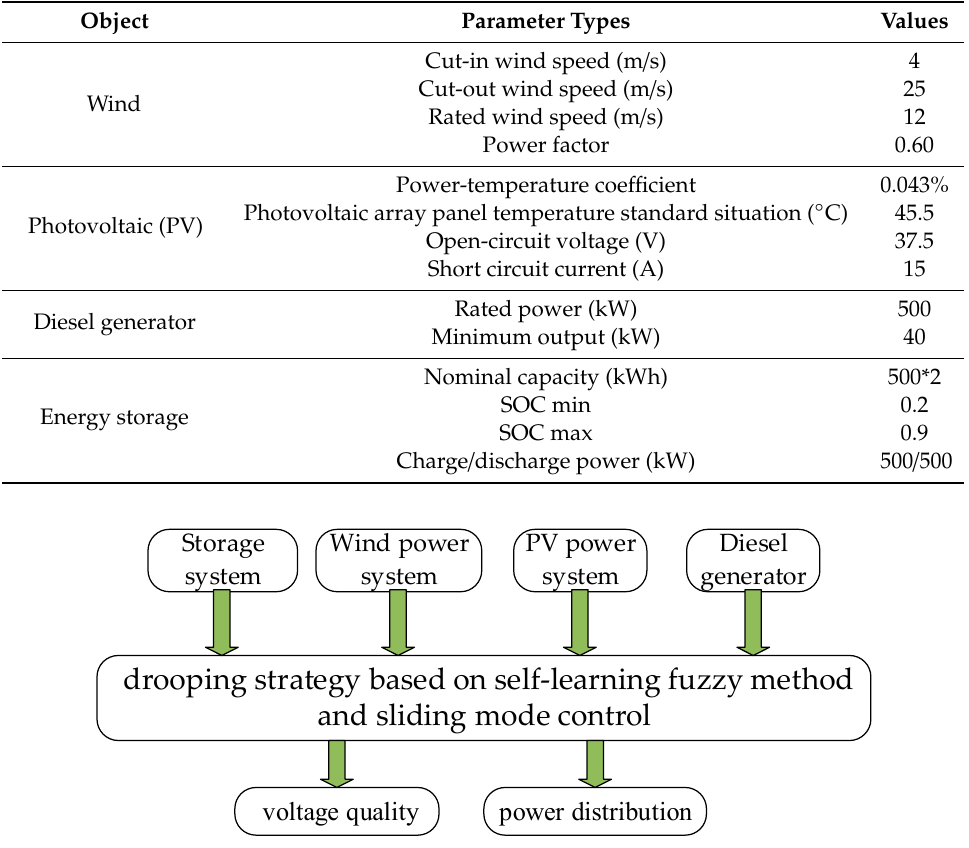
Table 3. Specific parameters of the microgrid platform.